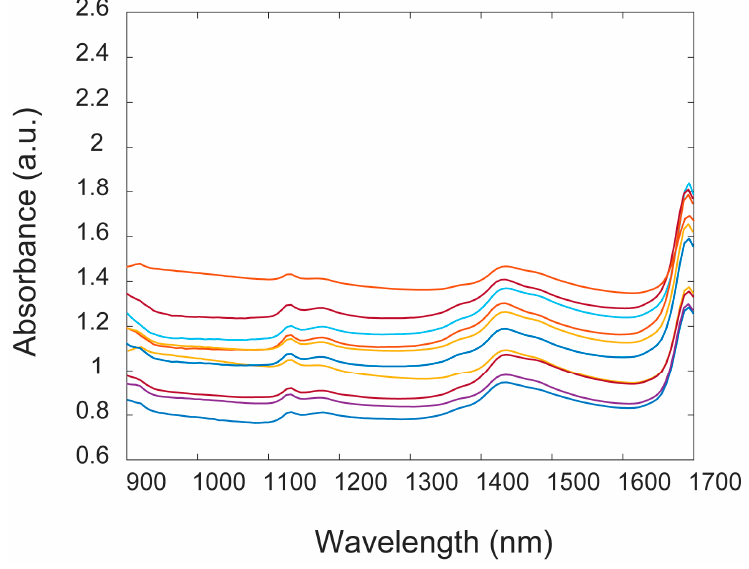
Figure A1. Representative NIR spectra of coloured PET samples.